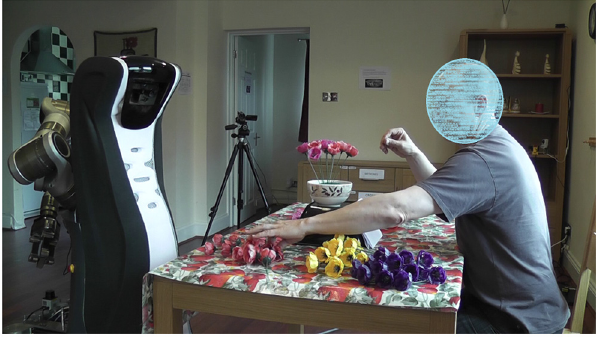
Fig 1. Experimental setup from side perspective showing the robot and the ‘ user ’